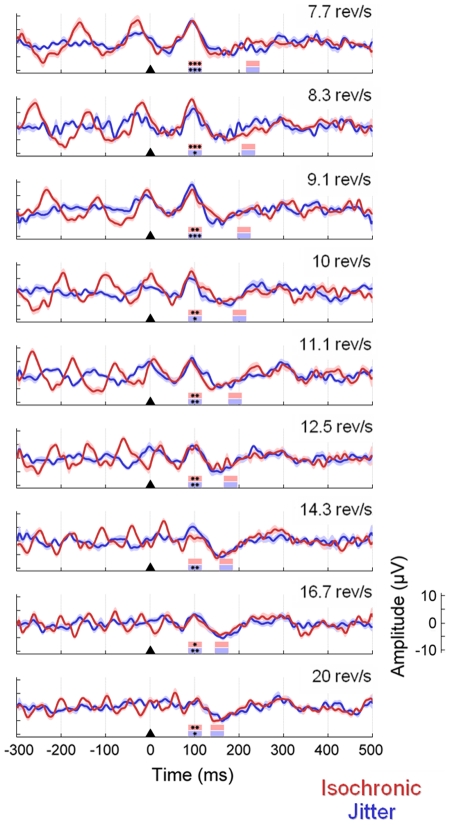
Absence of additional activity beyond the last stimulus of the sequence.The figure shows the grand-average ERPs time-locked to the last stimulus of the train for both isochronic (red lines) and jitter (blue lines) conditions from Experiment 2. The shaded area represents the standard error of the mean across subjects. Triangles indicate the onset of the last stimulus. The time window corresponding to the P100 component has been marked by the first column of coloured boxes (from 85 to 110 ms after stimulus onset; red: isochronic conditions; blue: jitter conditions). The time window corresponding to a potential additional response has been marked by the second column of coloured boxes, with different latency depending on stimulation rate. The asterisks indicate average responses significantly higher than 0 (*p<.05; **p<.01; ***p<.001); whereas the absence of asterisks indicates no significant responses (p>.05).